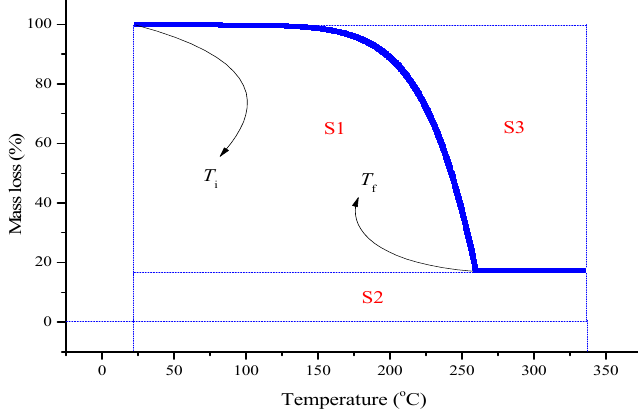
Figure 9. Schematic diagram for the conception of IPDT [23,24].